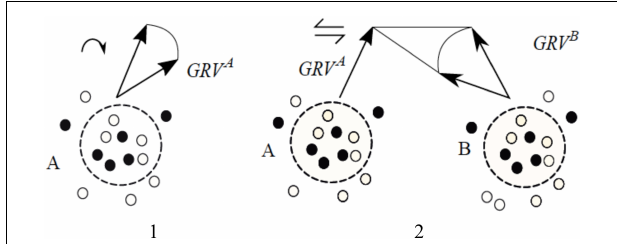
FIGURE 5 | (1) Patterns of excitation-inhibition within groups can be varied, which can be expressed as rotation of group response vectors (symbol (cid:121) denotes operation “rotation of group response vector”). (2) Movements of group response vectors can be coordinated: every position of GRV A determines a range of admissible positions for GRV B , and vice versa, movement of one vector causes re-positioning of the other one (i.e., thinking of changes in A brings to mind the corresponding changes in